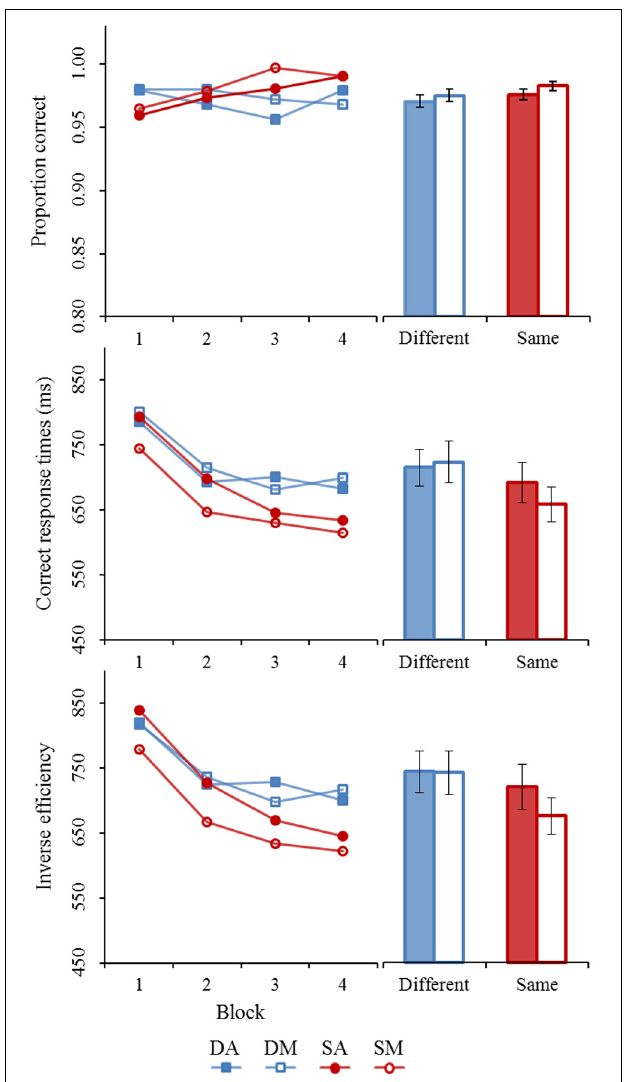
FIGURE 4 | Summary results of Experiment 1 (horizontal body composite effect). Each panel shows the averages for each block level (1–4) and for each trial type (different vs. similar). Averages across the blocks are also shown. Error bars represent standard error of the mean. (DA, different aligned; DM, different misaligned; SA, same aligned; SM, different misaligned).